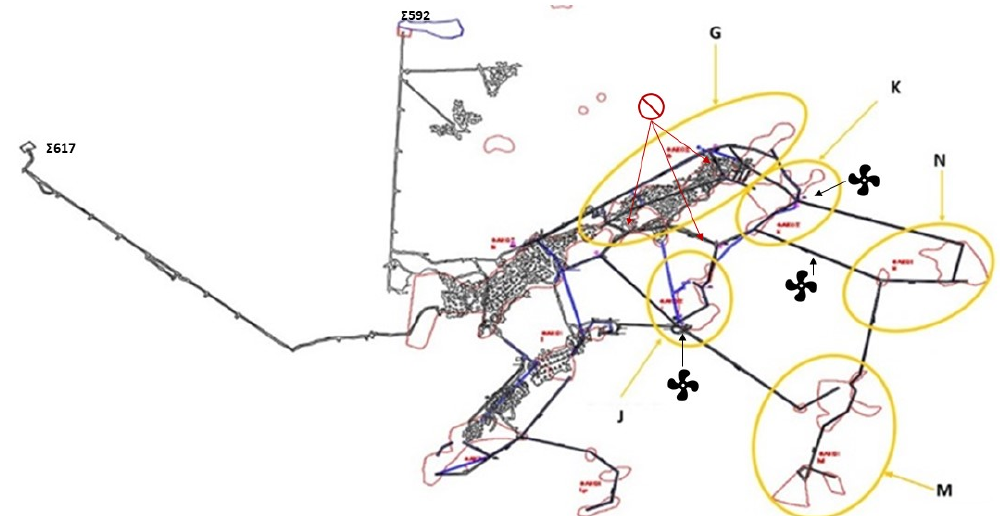
Figure 3. Map of future mine expansion project.